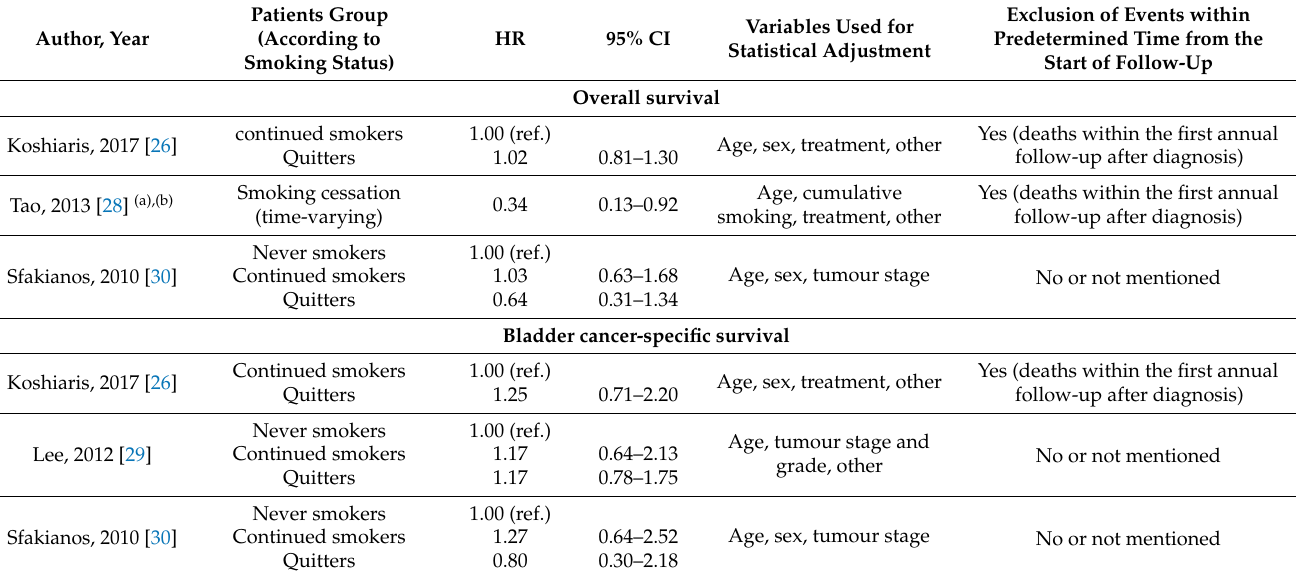
Table 3. Hazard ratio (HR), 95% confidence intervals (CI), and details of the statistical analysis for the association between at/around diagnosis smoking status (cessation/continuation) and bladder cancer overall and bladder cancer-specific survival.